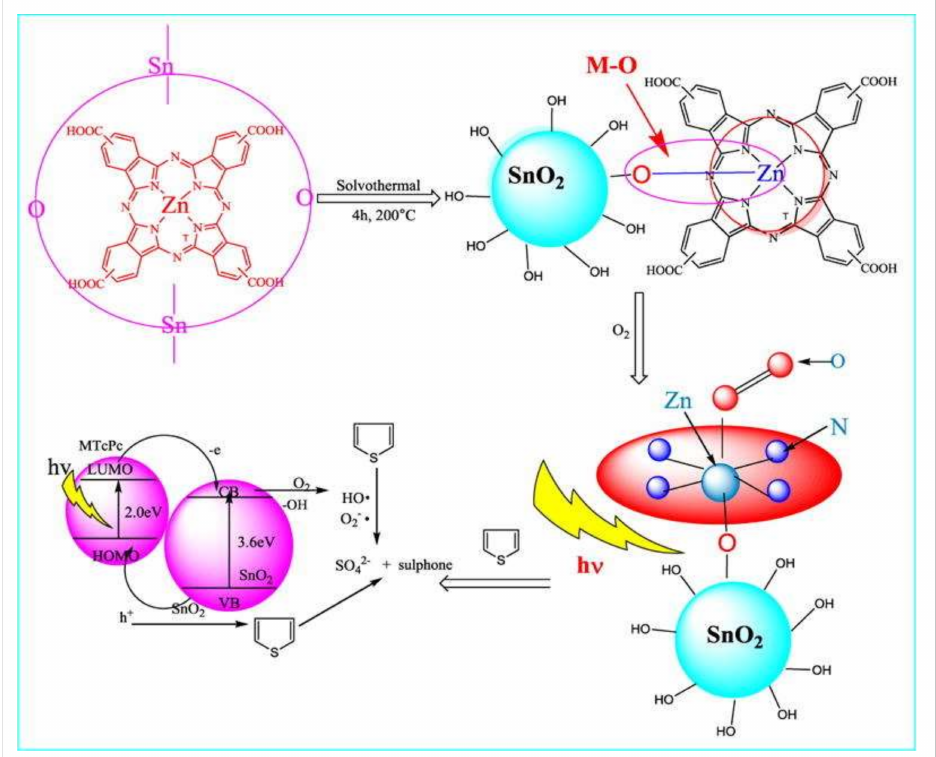
Figure 14. Mechanism of the formation of ZnTcPc/SnO 2 composites. Reproduced with permission from Ref. [147]. Copyright 2018